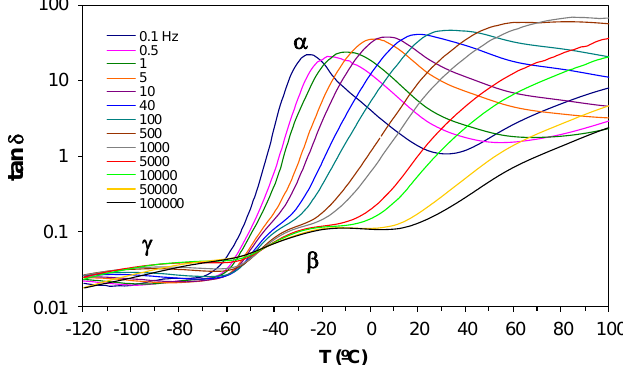
Figure 6. Dielectric relaxation spectroscopy (DRS) spectra for the HBPEI at a heating rate of 0.5 K/min.